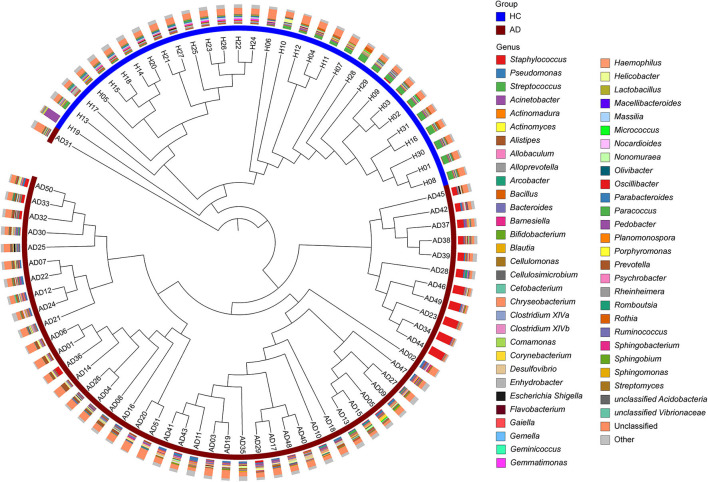
Hierarchical clustering of microbial samples from cutaneous sites. The 82 microbial samples [31 HC (blue) and 51 AD (maroon)] were clustered as determined by the Bray-Curtis distances. In the outer circle, the histograms show the relative abundances of the major microbial constituents in each sample. Three main branches can be identified: (I), samples from HC; (II), S. aureus-predominant AD patients (AD.S group), and (III) S. aureus-non-dominant AD patients (AD.ND group).